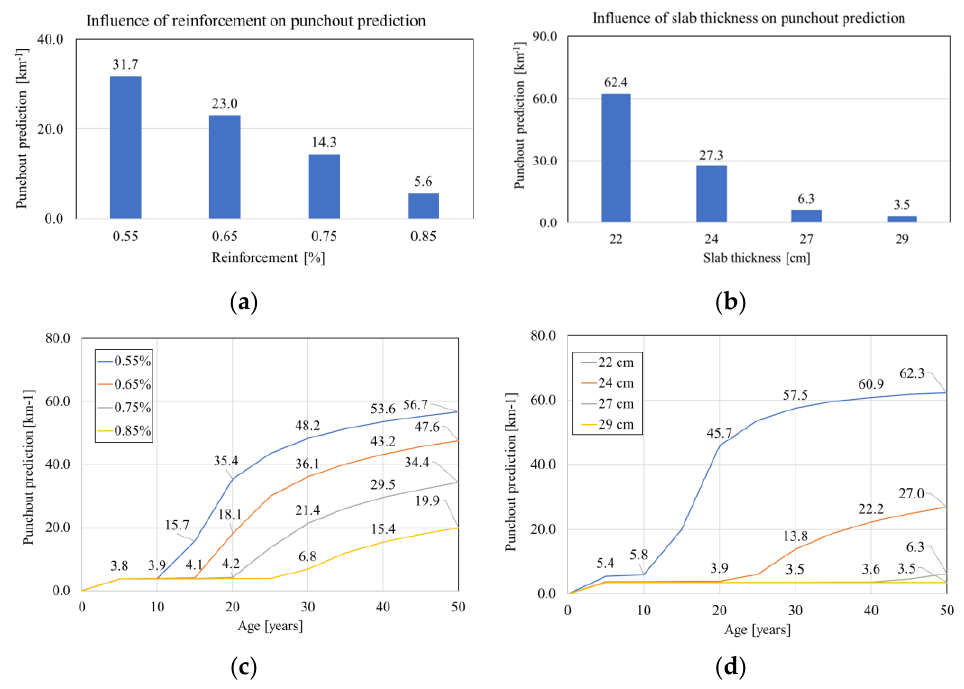
Figure 9. Sensitivity of punchouts to ( a ) reinforcement, ( b ) slab thickness, ( c ) reinforcement/age, and ( d ) slab thickness/age.